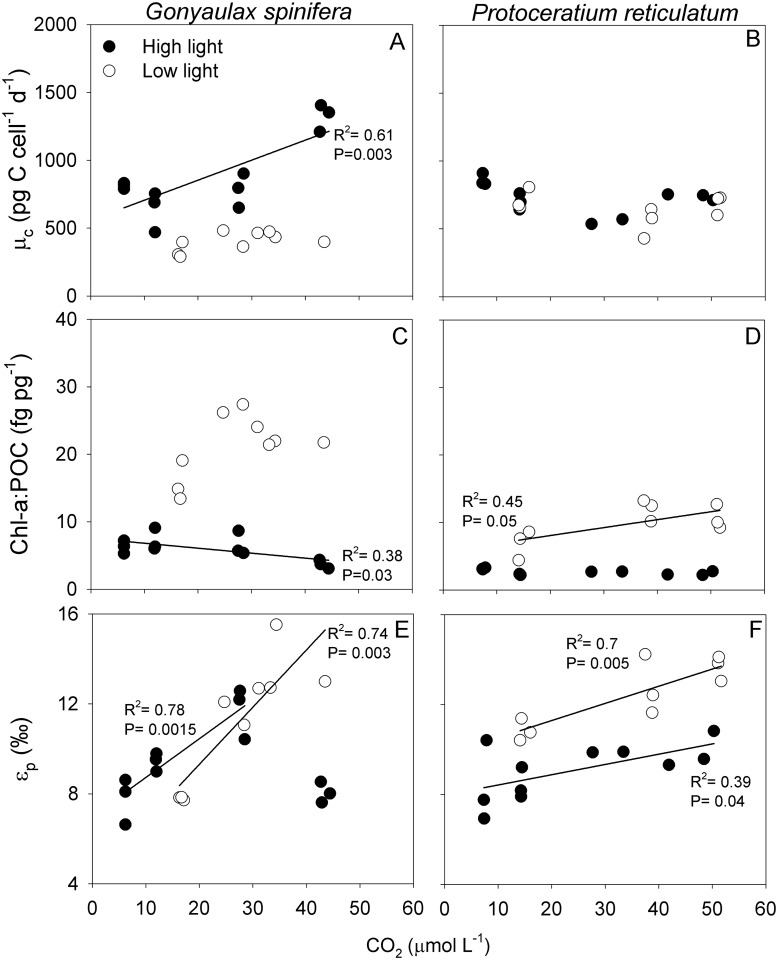
Combined effect of elevated pCO2 and light-limitation.(A, B) POC production, (C, D) Chl-a:POC ratios and (E, F) εp versus CO2 of G. spinifera (left) and P. reticulatum (right). Linear trend lines, R2 and P-values represent statistically significant relationships. Symbols indicate means of technical replicates. Means ± SD for all treatments are provided in Table 1. Note that the trend line for G. spinifera under HL excludes the highest pCO2 treatment (see also [16]). εp in the HL treatments have previously been published in Hoins et al. 2015.